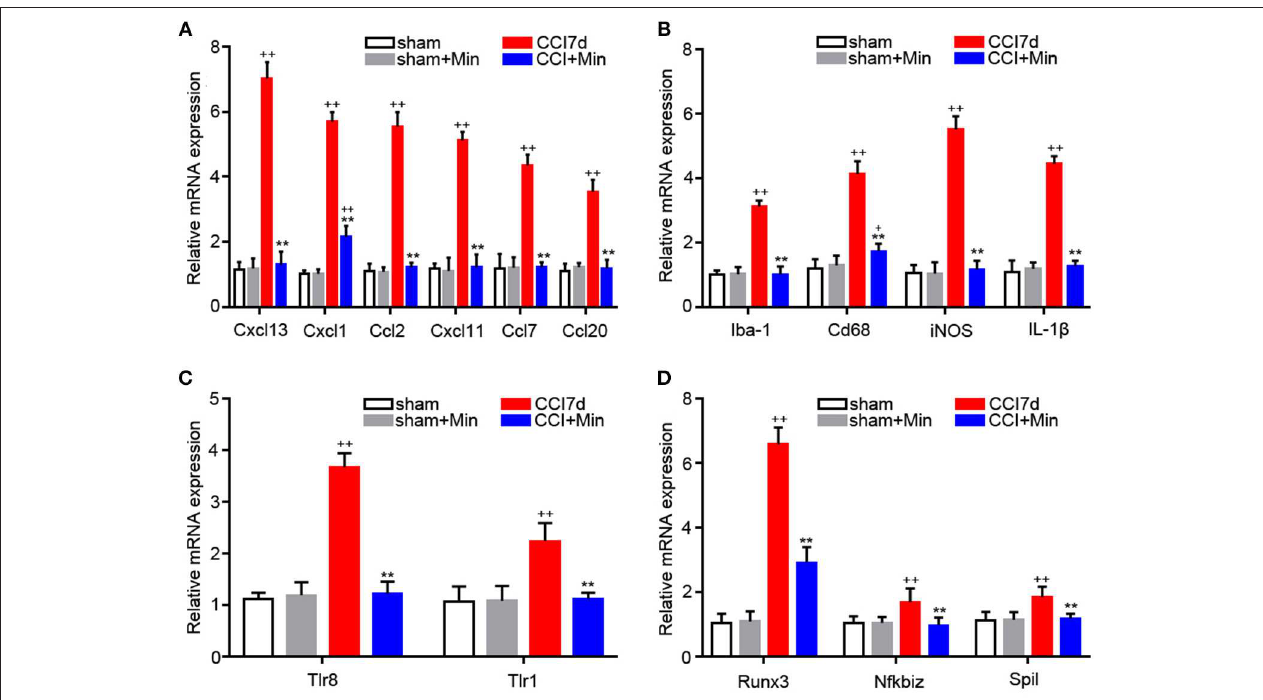
FIGURE 4 | RT-PCR showing the expression of Cxcl13, Cxcl1, Ccl2, Cxcl11, Ccl7, Ccl20, Iba-1, CD68, iNOS, IL-1 β , TLR8, TLR1, Runx3, Nfkbiz, and Spil mRNA in the rat hippocampus ( n = 6). + P < 0.05 and ++ P < 0.01, compared with both the sham and sham + Minociclyne groups; ** P < 0.01, compared with the CCI 7d group; this applies for all the genes. (A) The expression of CXCL13, CXCL1, CCL2, CXCL11, CCL7, CCL20 in the hippocampus. (B) The expression of Iba-1, CD68, iNOS, and IL-1 β in the hippocampus. (C) The expression of TLR8 and TLR1 in the hippocampus. (D) The expression of Runx3, Nfkbiz, and Spil in the